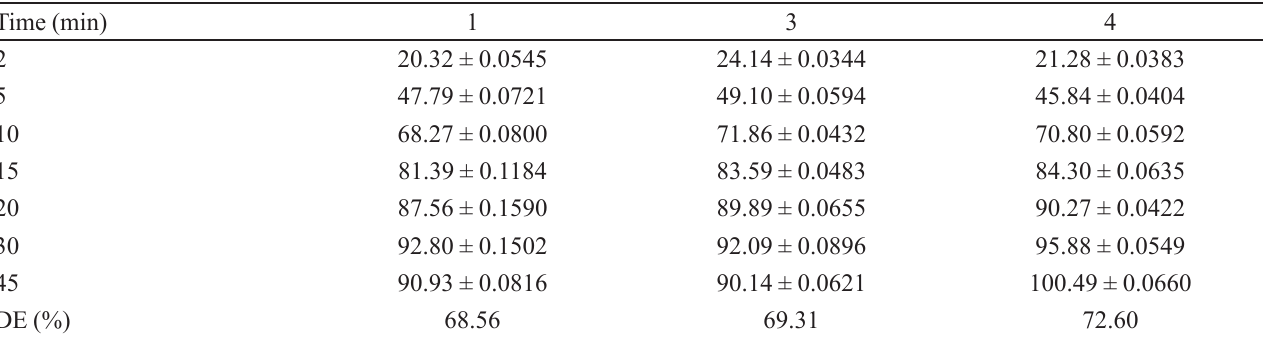
TABLE VI - Dissolved percentage (± standard-deviation) obtained for each formulation and the respective dissolution efficiency values (DE) in apparatus 1 (basket). n = 5 Time (min)